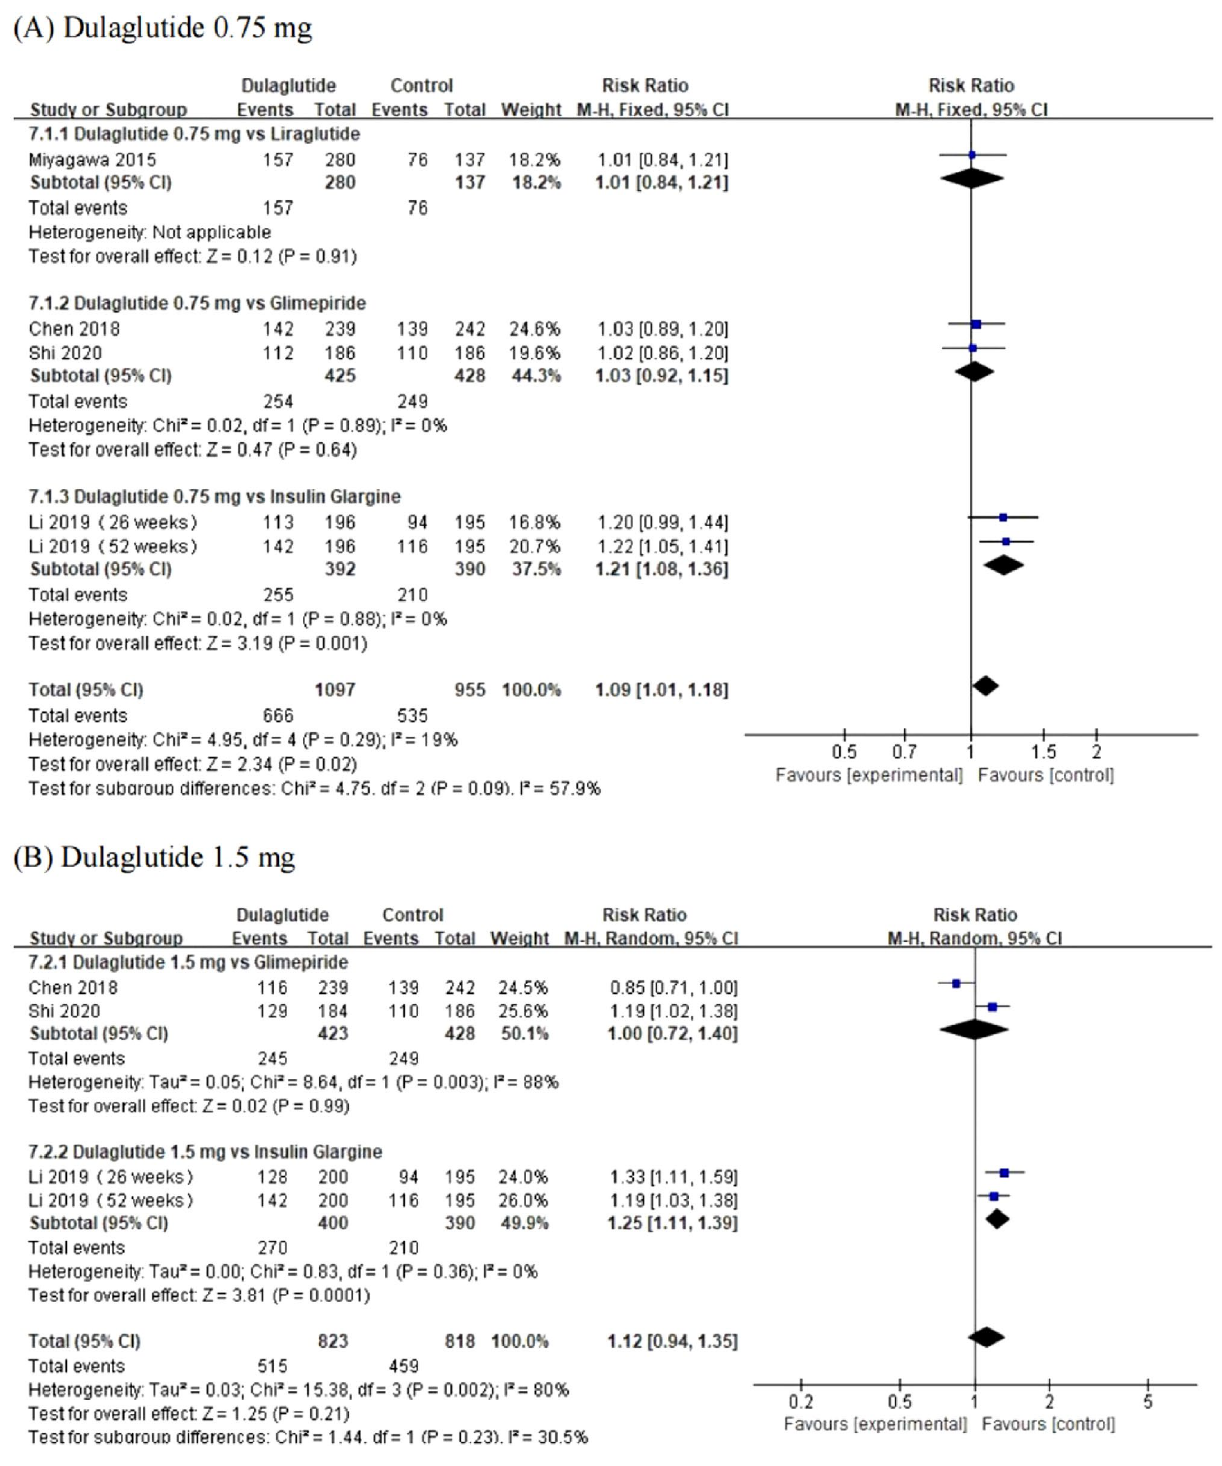
Figure 5. Forest plot of comparing adverse events between dulaglutide and first-line hypoglycemic